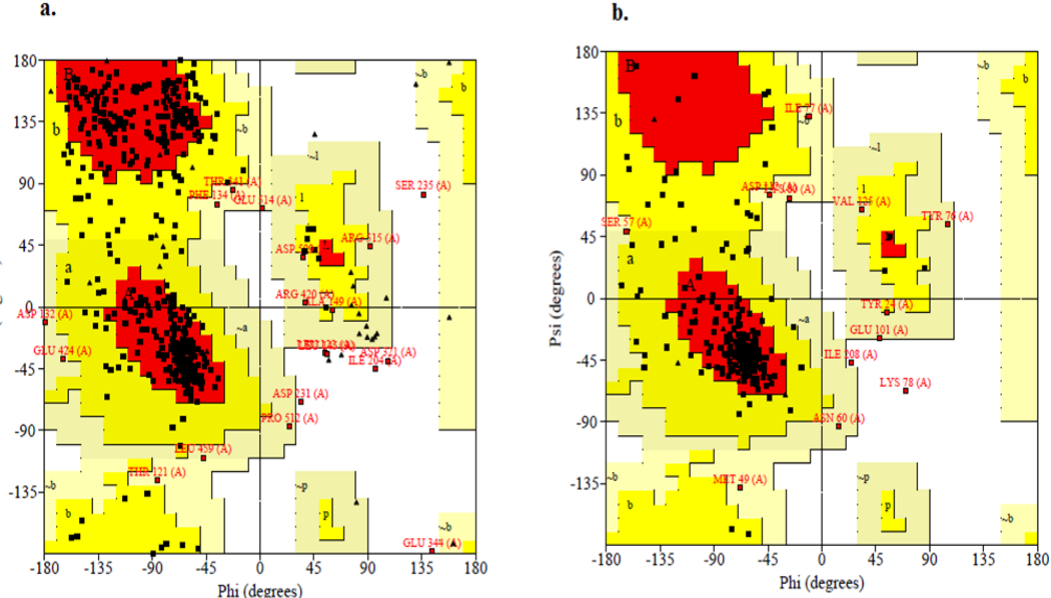
Figure 3. Assessing the quality of predicted Anthranilate-CoA ligase ( a ), and 1, 3- β –D-glucan synthase ( b ) structure.